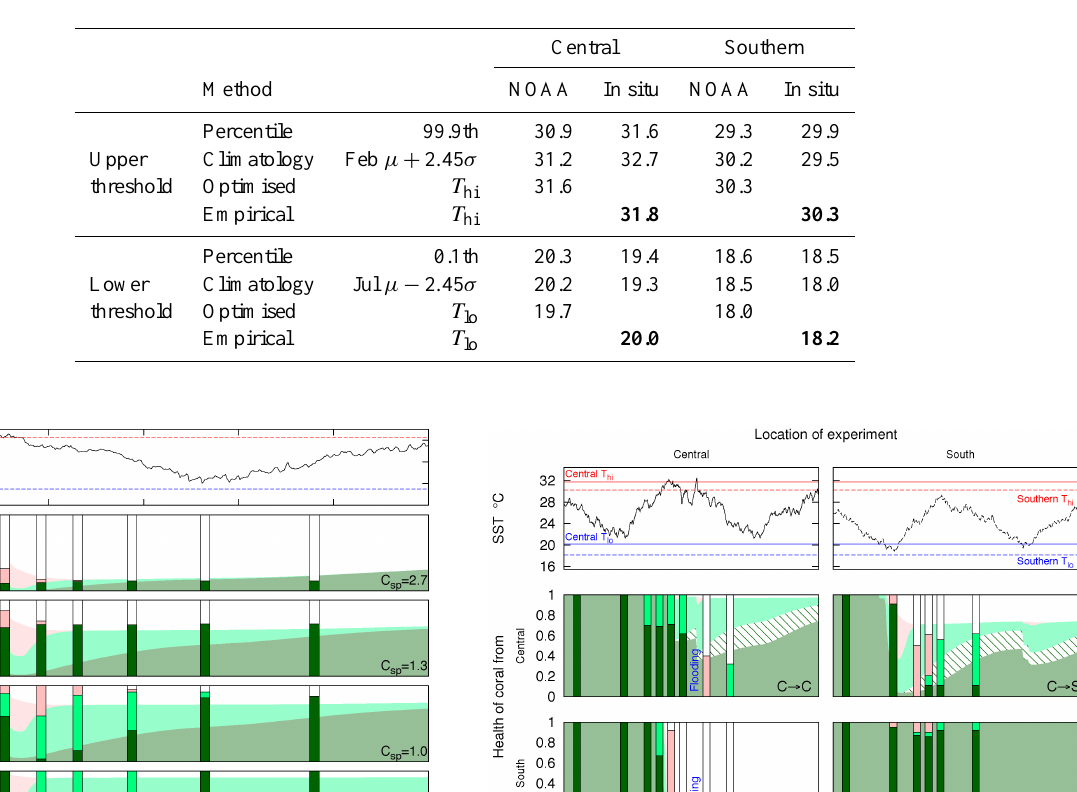
Table 4. Estimates of the adapted temperature range for the central and southern GBR sites in the reciprocal transplant experiment. The thresholds are calculated using a variety of methods and from two SST records. The empirically derived thresholds (bolded) are used in the model run shown in Fig. 11.